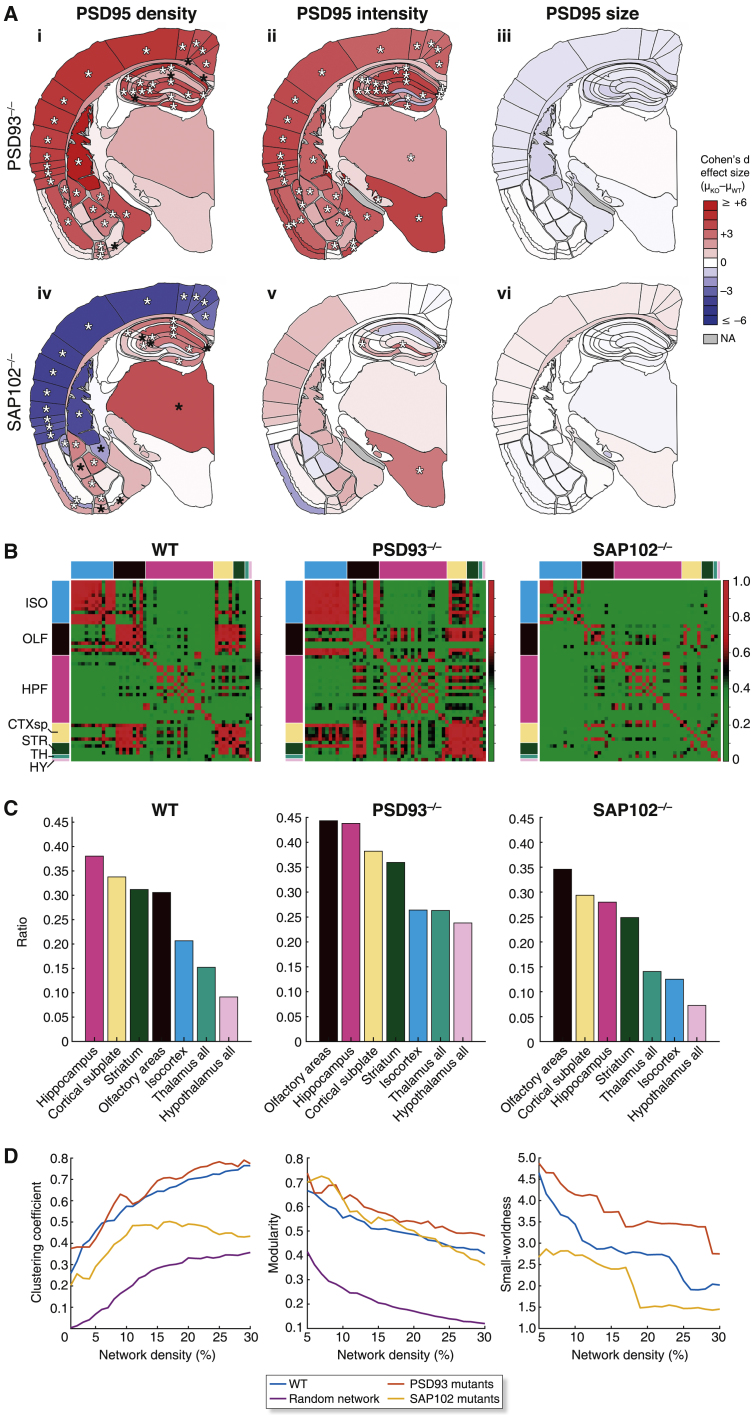
PSD93 and SAP102 Mutations Reprogram the PSD95 Synaptome(A) Cohen’s d values of changes in PSD95 punctum density (i and iv), intensity (ii and v), and size (iii and vi) in Psd93−/− mice (i–iii, n = 6) and Sap102−/− mice (iv–vi, n = 11) compared with wild-type (WT) mice (n = 13). Key, increase (red) or decrease (blue) relative to WT. Significance calculated using Bayesian estimation analysis with Benjamini-Hochberg correction: p < 0.05 (black asterisks), p < 0.01 (white asterisks). NA, not applicable. Raw values for PSD95 quantification in Table S4.(B) Subregion similarity matrices of PSD95 synaptome between pairs of subregions in WT, Psd93−/− and Sap102−/− mice.(C) Ratio of between-region to within-region similarities ordered from highest to lowest for regions in WT, Psd93−/−, and Sap102−/− mice.(D) Clustering coefficient (left), modularity (middle), and small-worldness (right) for WT, Psd93−/−, and Sap102−/− mice compared with a random-controlled network with an equivalent network complexity.